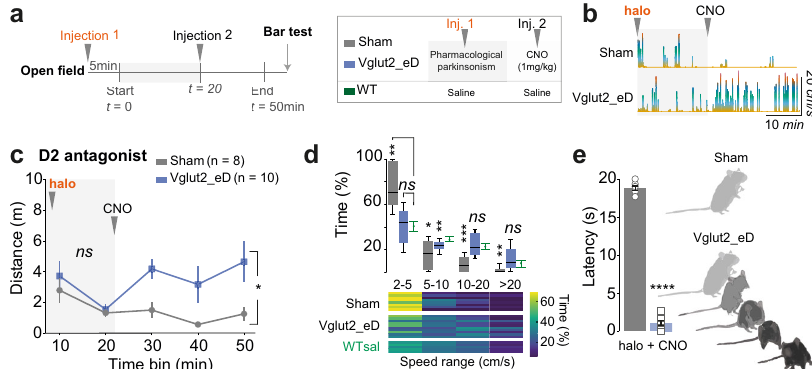
Fig. 2 Chemogenetic activation of glutamatergic PPN neurons rescues motor suppression induced by D2 receptor antagonism. a Chemogenetics experimental paradigm used to pharmacologically induce a parkinsonian motor phenotype (injection 1, light-gray background) and evaluate locomotor output after CNO (injection 2). Subsequently, mice were challenged with the Bar test to measure latency for motor initiation. Right panel shows the design of experimental groups. b Motion tracking with instantaneous speed pro fi le in the Open Field (speed follows the divergent color scheme to facilitate reading). Mice injected with haloperidol ( “ halo ” ) develop sustained immobility which can be counteracted by activation of caudal glutamatergic PPN neurons. c Timeline effect of D2 antagonist, haloperidol, before (light-gray background) and after injection of CNO in Sham (gray) and Vglut2_eD (blue) mice (Two-way RM ANOVA with graph reporting group effect and analysis done for each period separately). Data are presented as mean ± SEM. d Upper panel shows speed range in Sham (gray) and Vglu2_eD (blue) mice after CNO treatment in comparison to WT saline group (green). Min-to-max boxplots (Two-way RM ANOVA, Geisser – Greenhouse correction, report shows Dunnett ’ s vs WT sal + sal ). Lower panel heat map with individual mice in horizontal lines and color code for percent of the time in each speed range. e Average motor initiation latency observed in the Bar test (20 s limit) for Sham (gray) and Vglut2_eD (blue) mice treated with haloperidol and then CNO. Individual values represent the average of three sequential trials/mouse (two-tailed, non- matched, Mann – Whitney test). The illustration shows motor response by Vglut2_eD halo + CNO mice as they descend from the bar and move away from the initial position, whereas Sham halo + CNO mice remain akinetic holding the half-reared start position. Data are presented as mean ± SEM. Data composed of